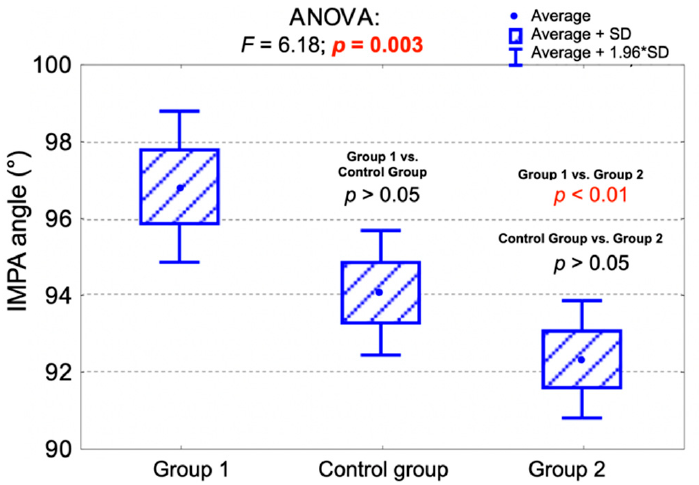
Figure 4. Comparison of the average IMPA angle values among the examined groups and the results of the analysis of variance (ANOVA). IMPA—incisor mandibular plane angle.